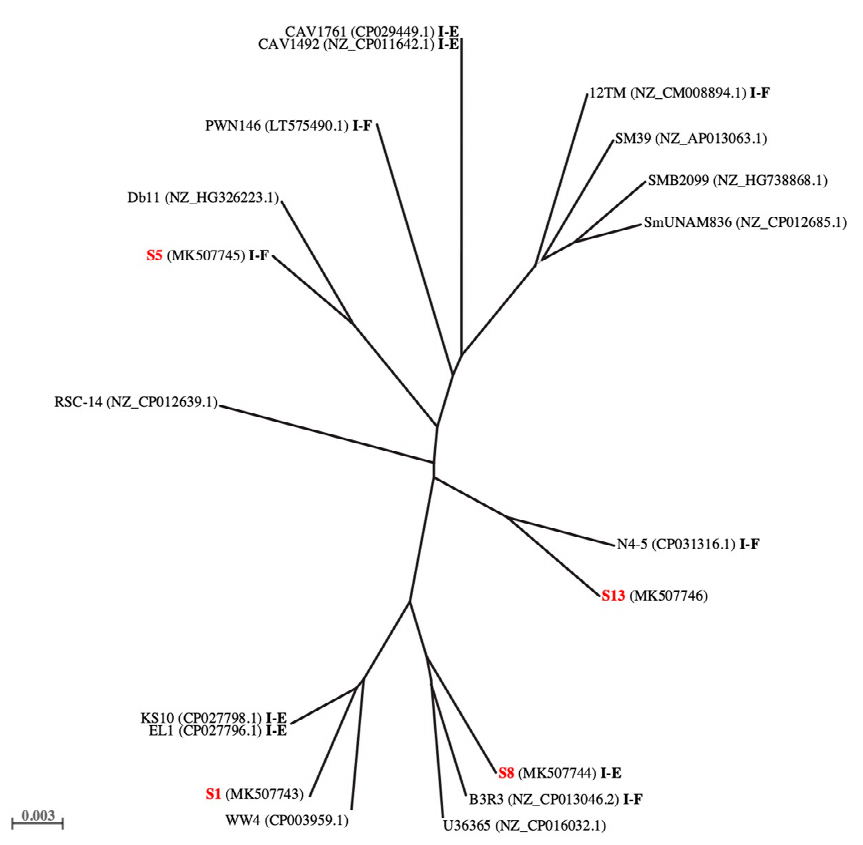
Figure 2. Phylogenetic tree. The phylogenetic tree was obtained from comparative analysis of the genomic region extending from the gene for tRNA Leu to phnF in S1, S5, S8, and S13 (in red) and S. marcescens complete genomes available from the NCBI database. System types are highlighted in